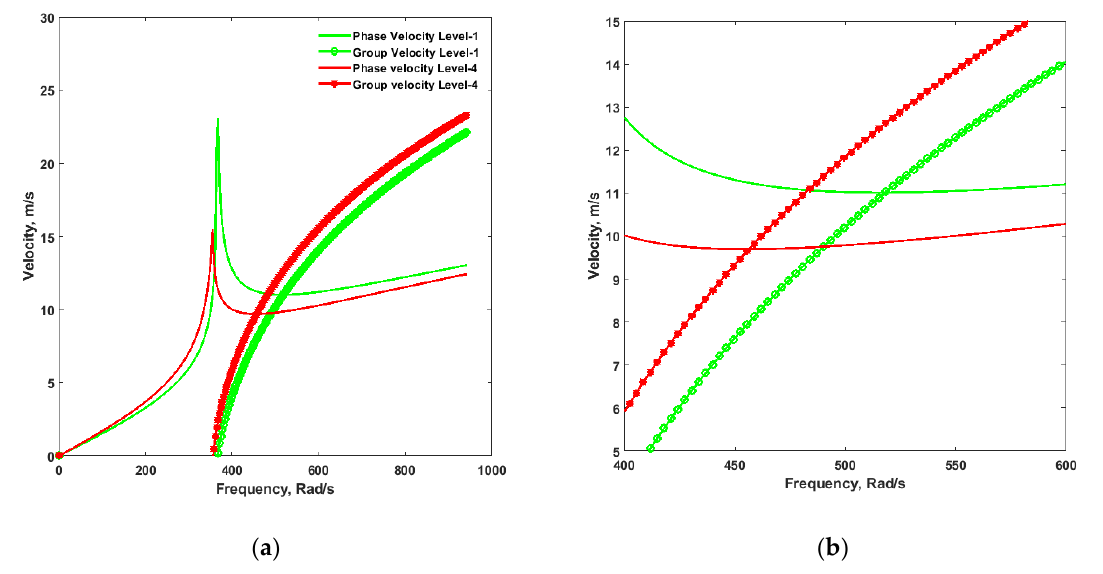
Figure 4. ( a ) Comparison of Dispersion Curves for Level-1 and Level-4, ( b ) Close View of ( a ).